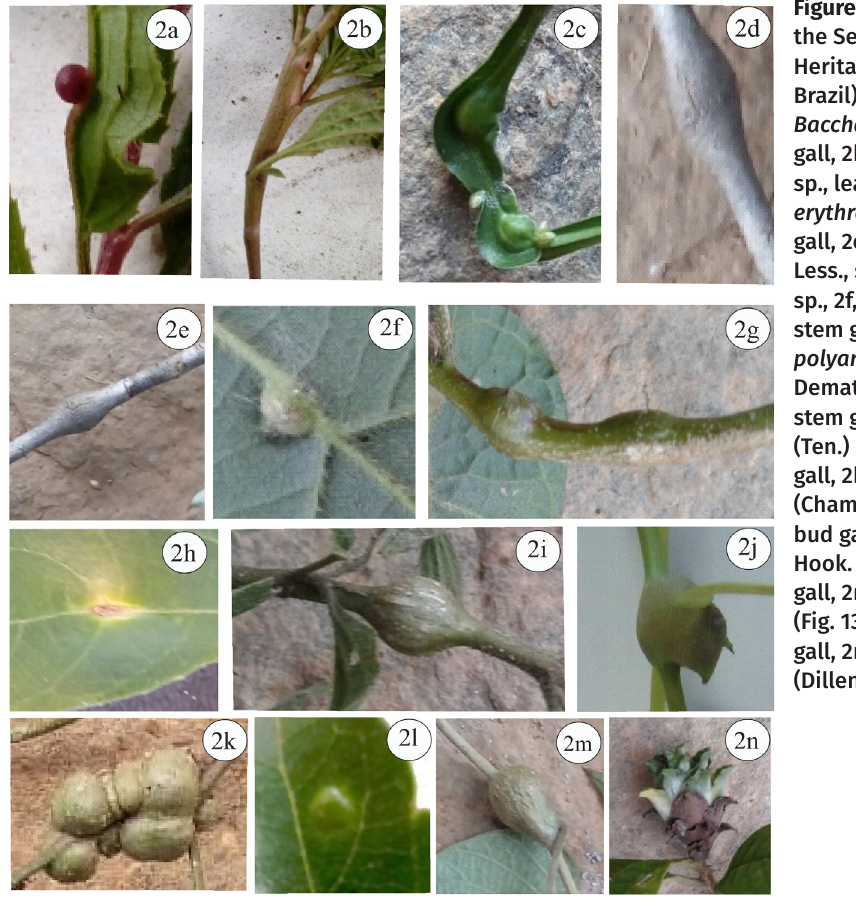
Gall (Fig. 2j): on bud, globoid, brownish, glabrous, one-chambered. Gall-inducer: Cecidomyiidae. First gall record on this plant family.